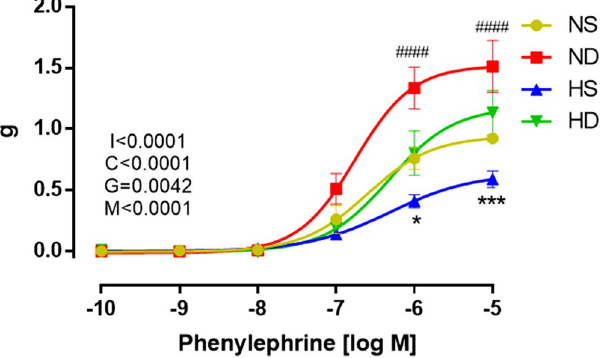
Figure 5. Concentration–response curve to phenylephrine. NS: normotensive sham (n = 6); ND: denervated normotensive (n = 9), HS: SHR sham (n = 5); HD: denervated SHR (n = 4). Data were analyzed by two-way ANOVA followed by Fisher post hoc test. Values are mean ± SEM. ANOVA: Interaction factor (I); Concentration factor (C); Groups factor (G); Matching (M). ####p < 0.0001 NS vs . ND; *p < 0.05; ***p < 0.001 HS vs .